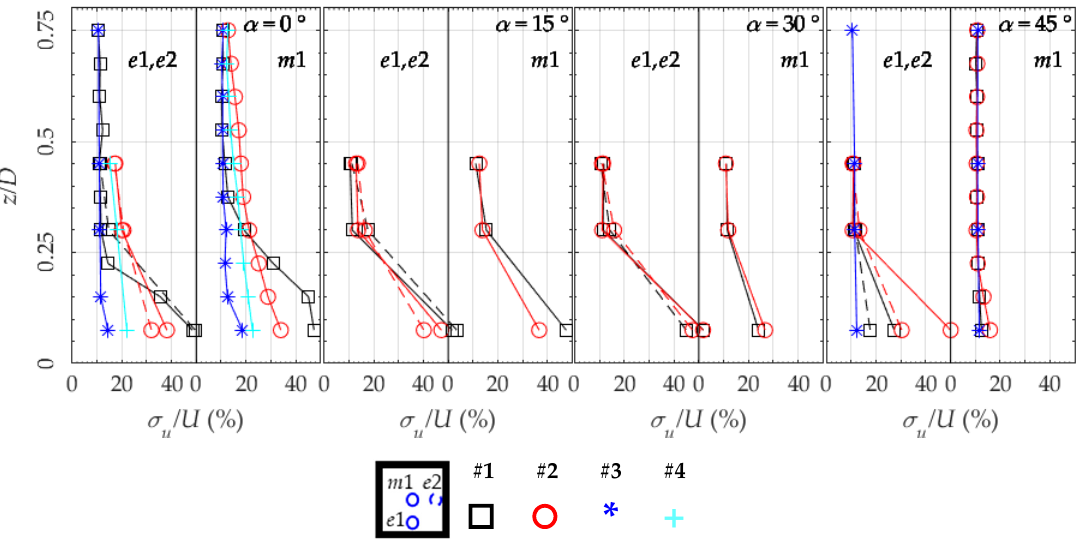
Figure 12. Longitudinal turbulence intensity I u at windward and leeward edges ( e 1, e 2) and centre locations ( m 1). Symbols as indicated in the legend, for the four configurations and wind directions.